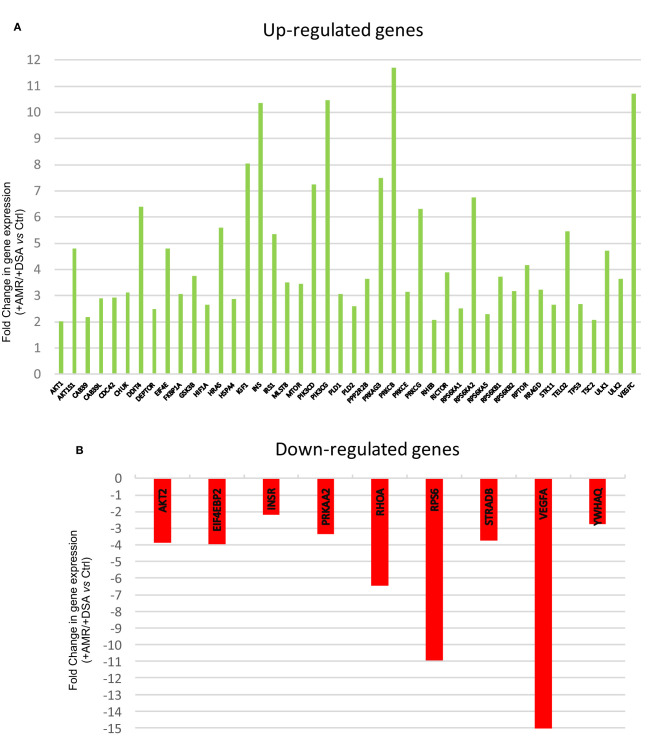
Differentially regulated mTOR pathway genes. (A) Up-regulated mTOR pathway genes (B) Down-regulated mTOR pathway genes.